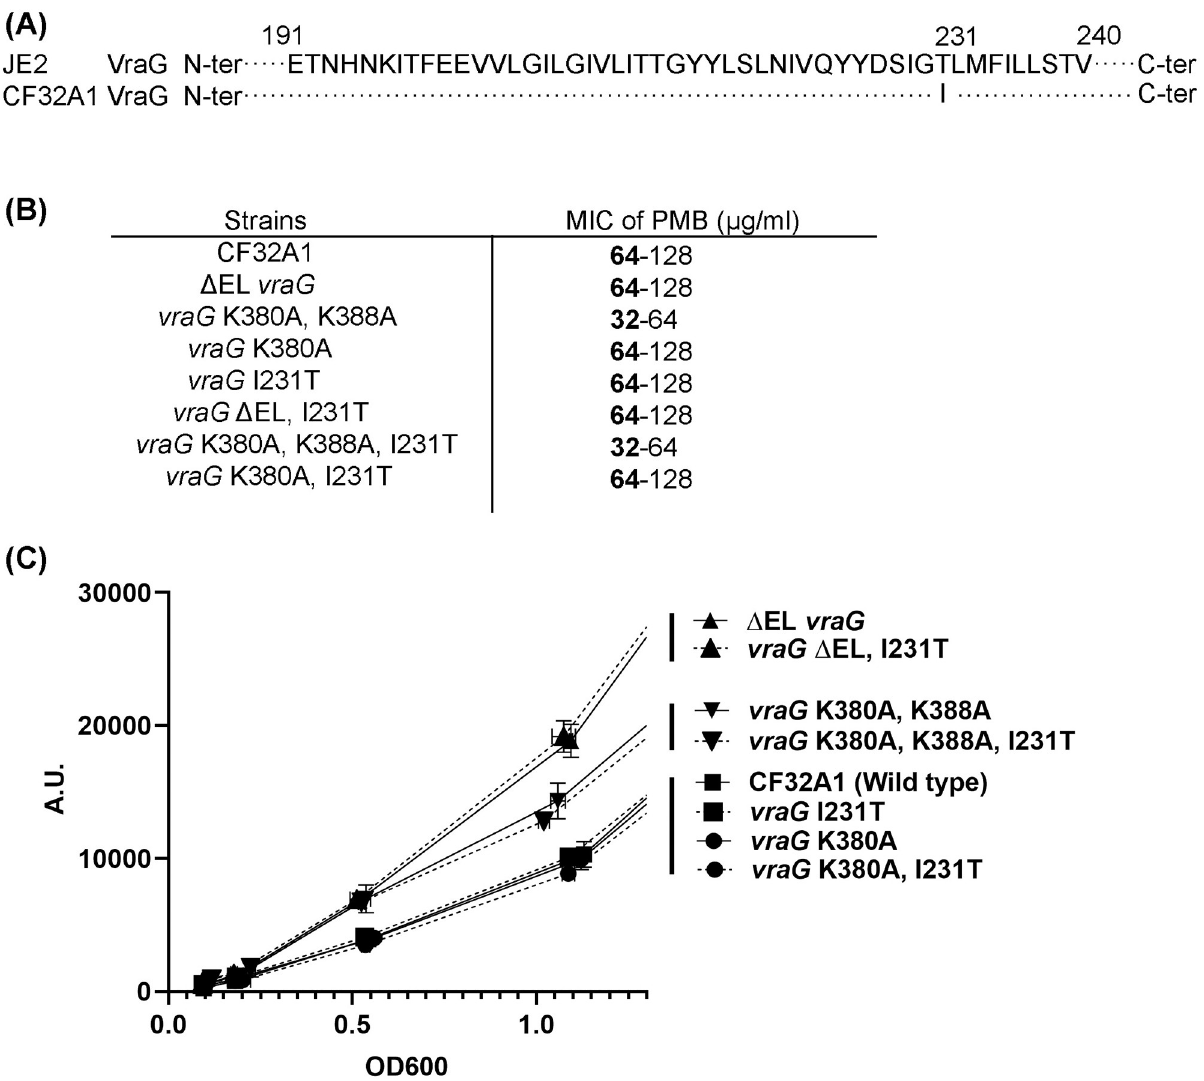
Fig 2. Missense mutation I231 in VraG. (A) Comparison of VraG sequence in CF32A1 vs. JE2. (B) MIC of PMB for vraG mutants. Median values from three biological replicates are marked in bold. (C) The expression of mprF promoter fused with a GFPuvr reporter in assorted strains. The dashed lines indicate the mutants with vraG